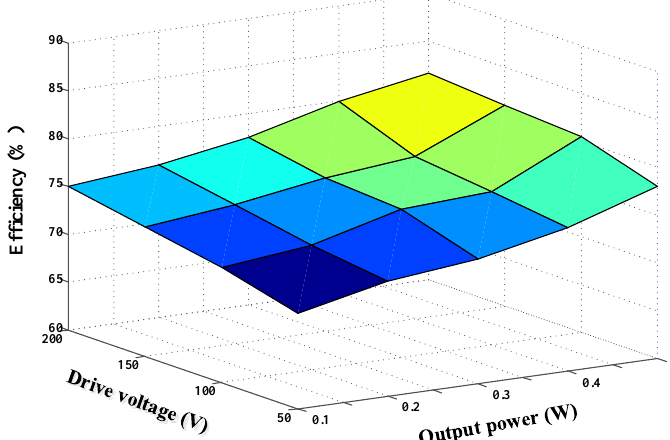
Figure 18. Efficiency of the half-bridge stage vs. drive voltage and output power.